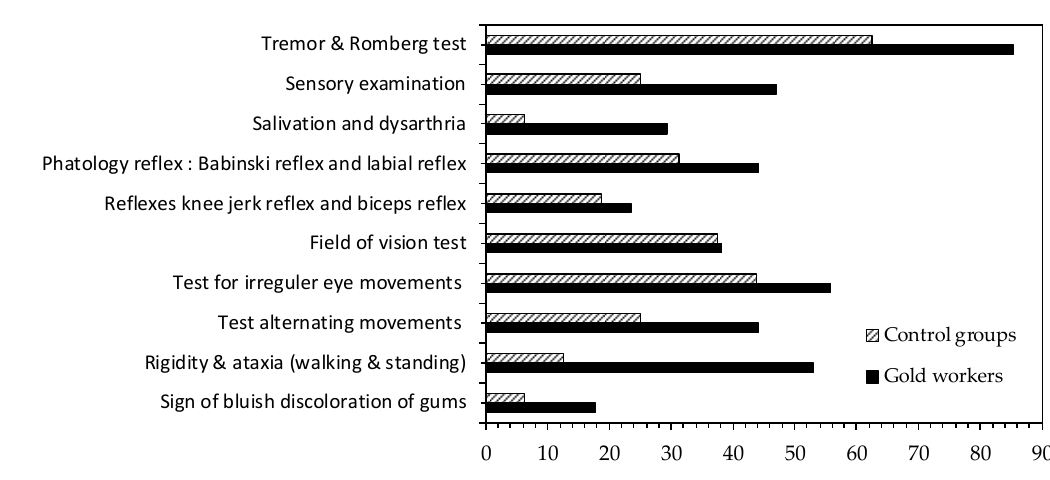
Figure 4. Occurrences of the 10 neurological symptoms in the control group and gold workers.